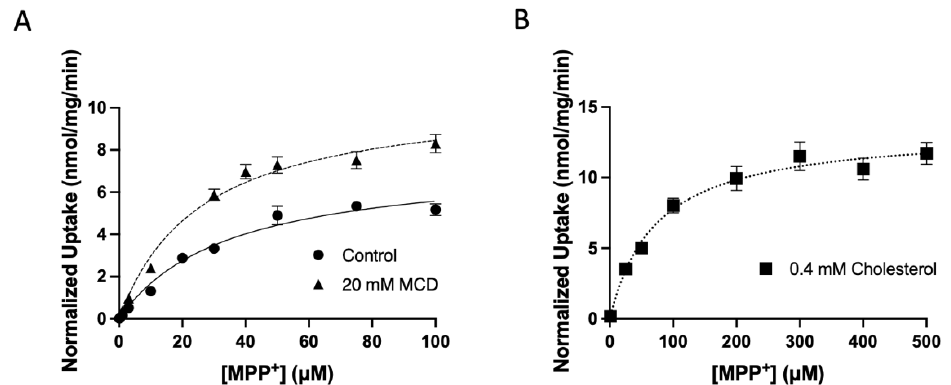
Figure 8. Normalized kinetics of OCT1-mediated MPP + uptake after treatment with ( A ) MCD or ( B ) cholesterol. Uptake of increasing concentrations of MPP + was measured at 37 °C for 15 s in EV and OCT1-expressing HEK293 cells in sodium-containing buffer and corrected for protein. Net uptake was calculated by subtracting the uptake measured in EV cells from the uptake measured in OCT1- expressing cells and then correcting for OCT1 surface expression. Values are means ± SEM of at least three independent experiments performed in triplicates. Curves were fit with the Michaelis – Menten equation in GraphPad Prism. Table 1. Kinetic parameters after normalization for surface expression. Kinetic parameters, K m and V max , were calculated using the Michaelis – Menten equation in GraphPad Prism and are reported as the average ± SEM of at least three independent experiments performed in triplicates; asterisks in- dicate a p < 0.05.